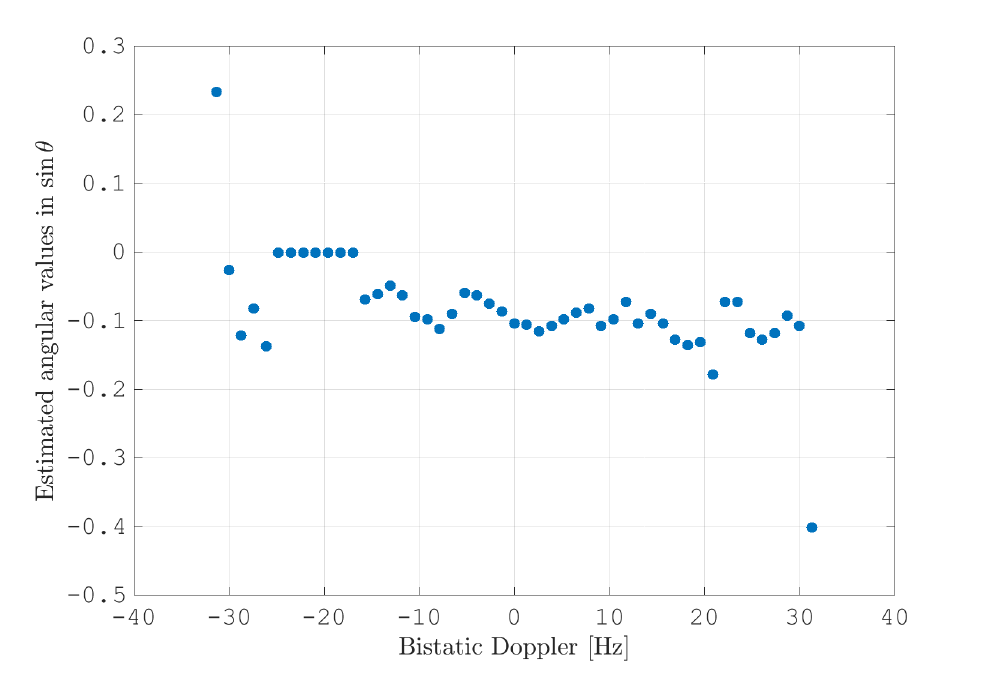
( Tx ) = − 11Hz D ( Tx ) were excluded D